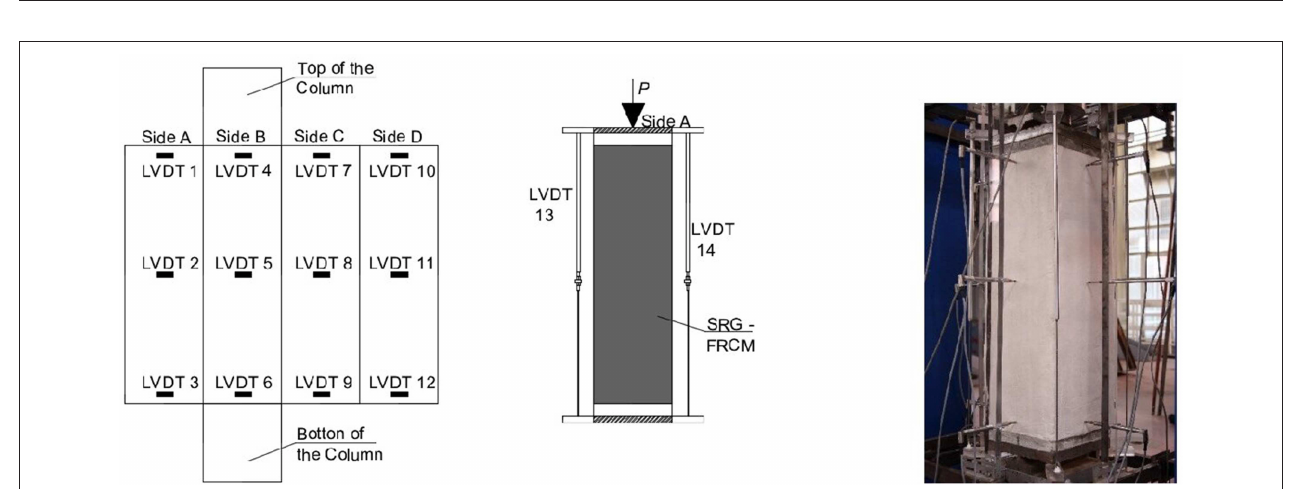
FIGURE 7 | Steps to confine columns with one layer of composite material: (A) installing the internal mortar layer, (B) installing the sheet/fabric mesh, and (C) installing the external mortar layer.